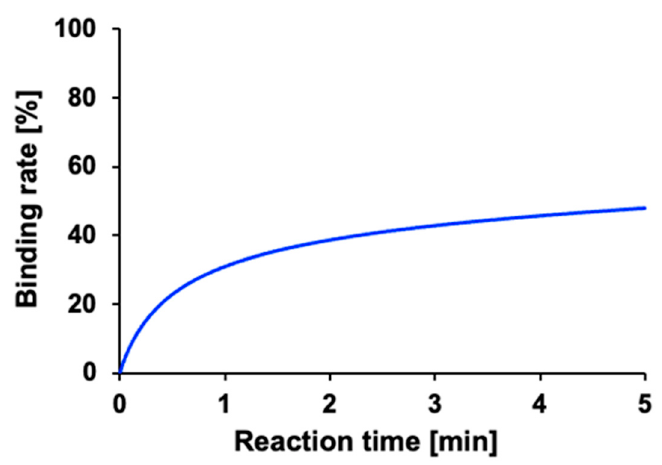
Figure 7. Calculated increase in binding rate during steady rotation.